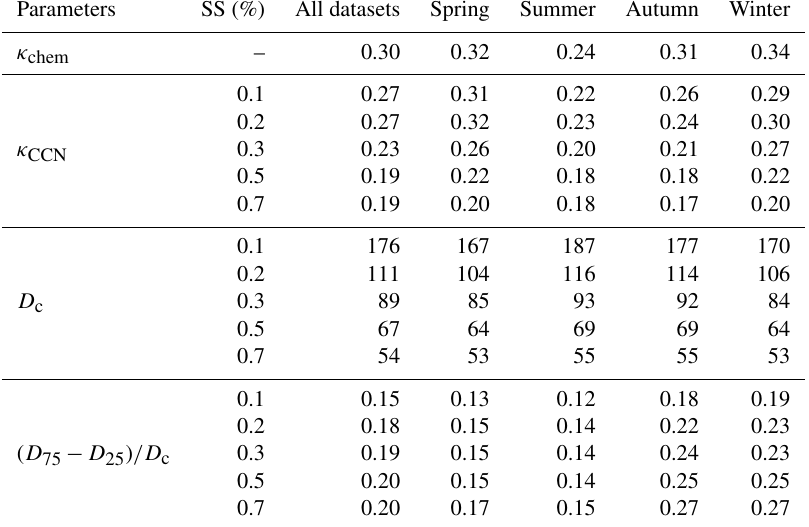
Table 2. Seasonal median values of the hygroscopicity factor derived from the chemical composition ( κ chem ), the hygroscopicity factor derived from monodisperse CCN measurements ( κ CCN ), the critical diameter of dry particle for activation ( D c ), and the degree of external mixture (( D 75 – D 25 )/ D c ) at each supersaturation (SS) condition. The unit of D c is nanometers